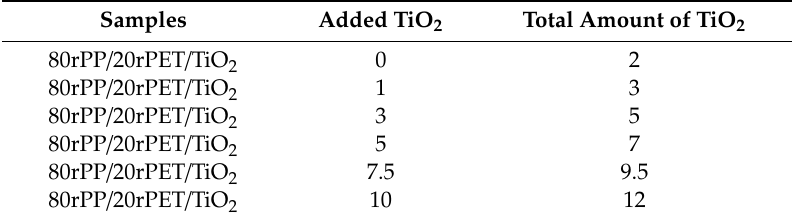
Table 1. Compositions of the prepared polymer blend nanocomposites (PBNANOs) in w / w . Samples Added TiO